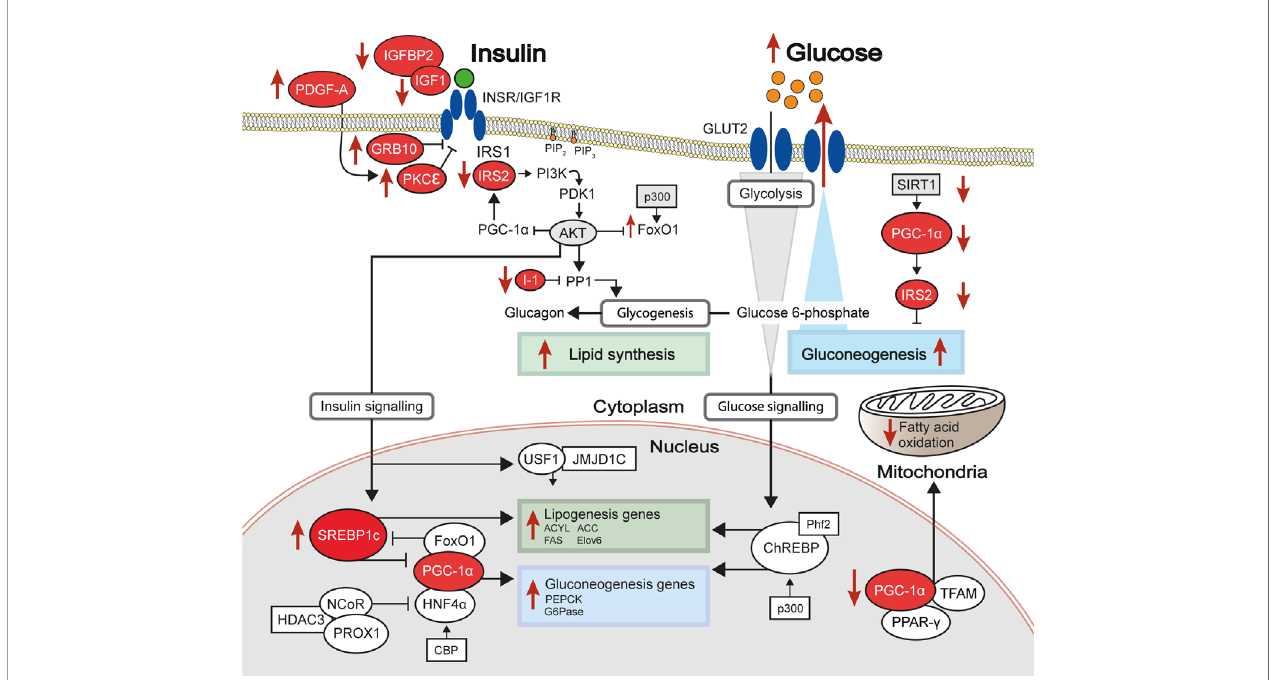
FIGURE 2 | Differential methylation of insulin signalling pathway genes in insulin resistant states. The insulin signalling pathway, with key proteins encoded by genes showing differential levels of DNA methylation in insulin-resistant states highlighted in red. Red arrows indicate increased (up) or decreased (down) gene expression and activity of the indicated signalling pathways in hepatic insulin